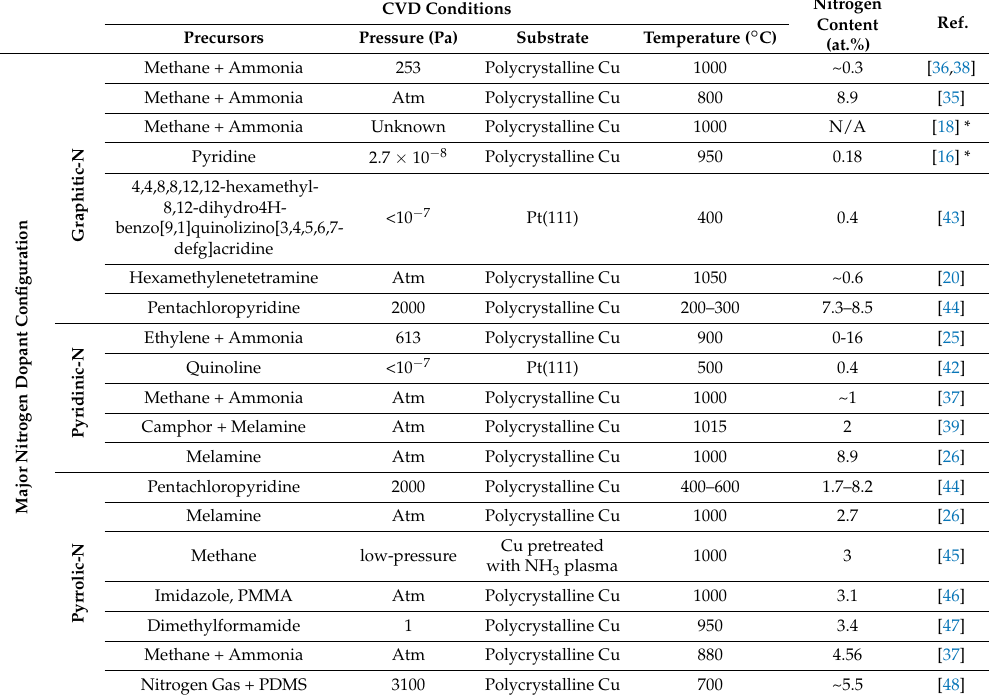
Table 1. In situ NG preparation method and associated bonding